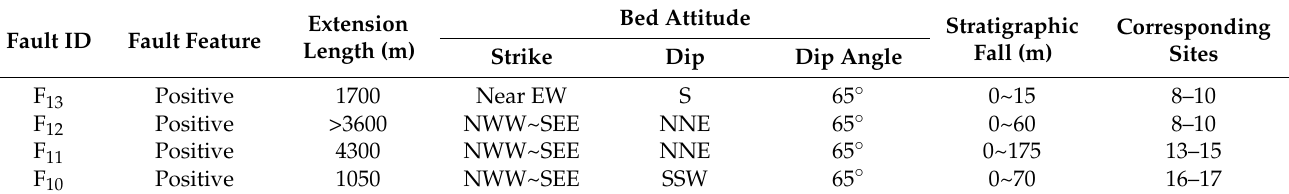
Table 3. Statistical characteristics of faults in collapse-type coal mine goaf